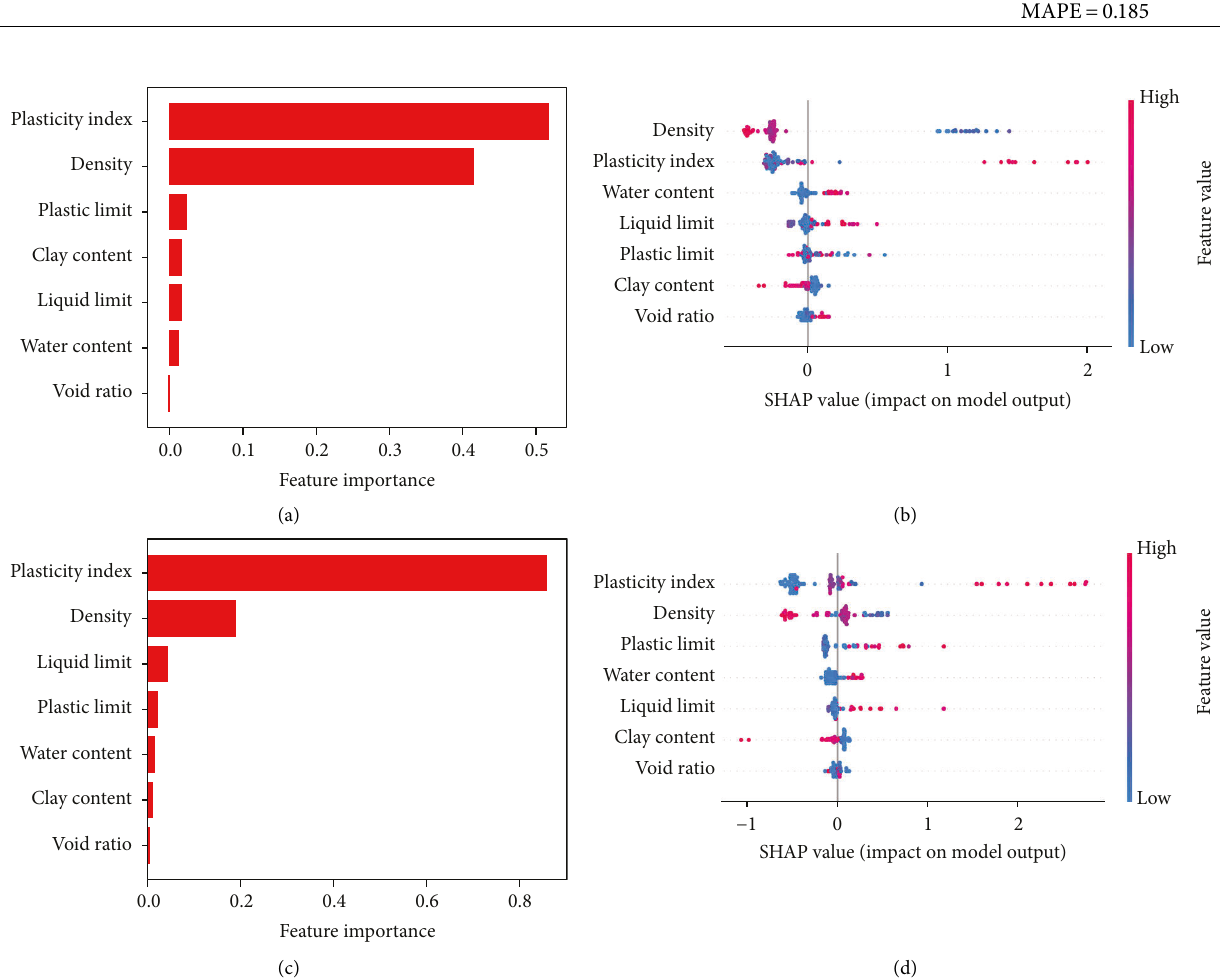
Figure 6: Feature importance analysis with (a) RF model-based permutation and (b) RF model-based and (c) GB model-based permutation; and global interpretation SHAP value with (d) GB model-based influence of input variable on the permeability coefficient of